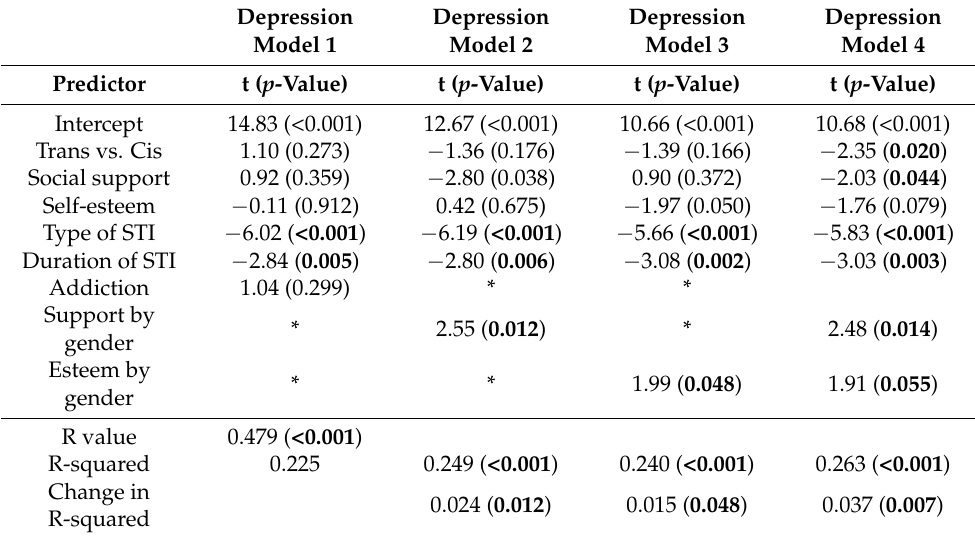
Table 3. Regression results for predicting